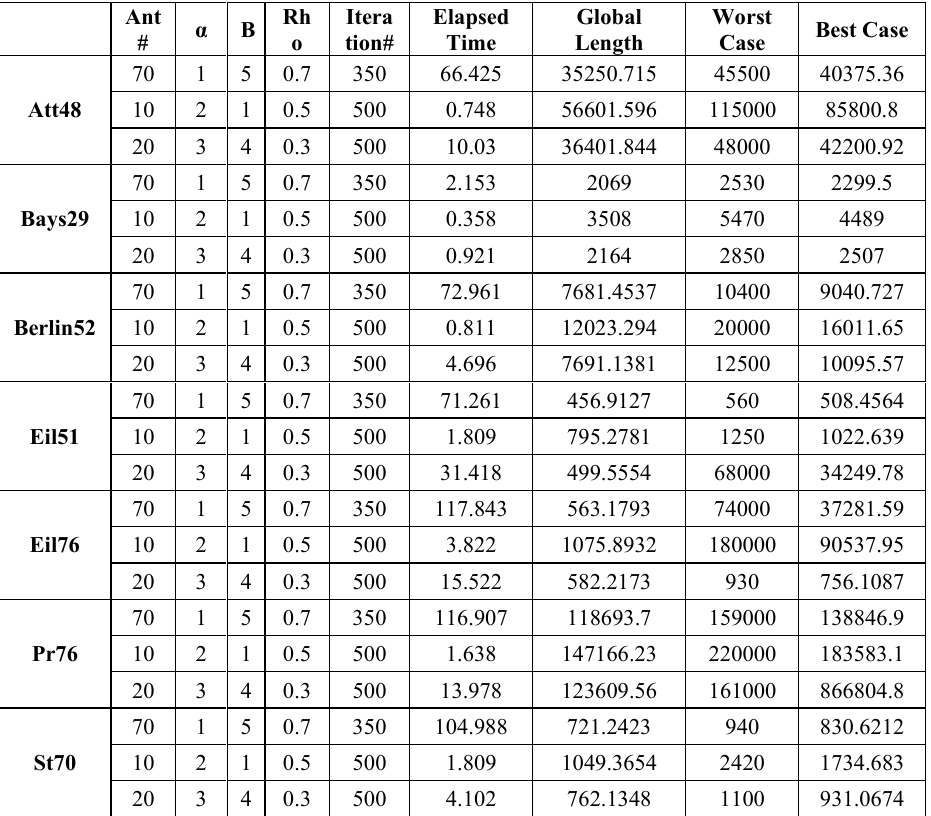
Table 1. Tabulation of the experimental results of Ant System